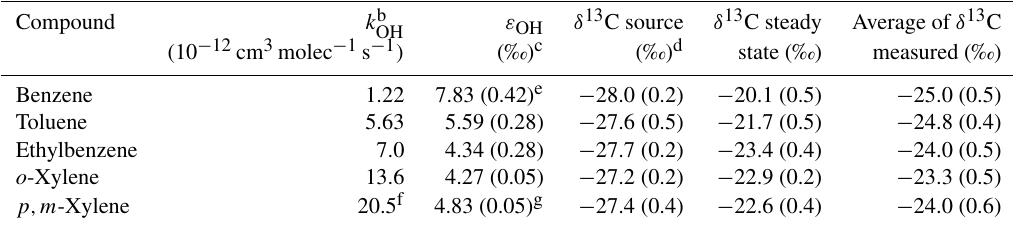
− 1.64 (1.63) a Standard error of intercept (‰) in parenthesis. The values are for linear fits of the mixing ratio of the more reactive VOC vs. the mixing ratio of the less reactive VOC. b No significant correlation was found for linear regressions of the mixing ratios of any of the VOC vs. the mixing ratios of benzene. Table 10. Summary of kinetic data, carbon isotope ratio of emissions, carbon isotope ratio calculated for steady state between emission and loss, and average measured carbon isotope ratio for light aromatic VOC a . Compound